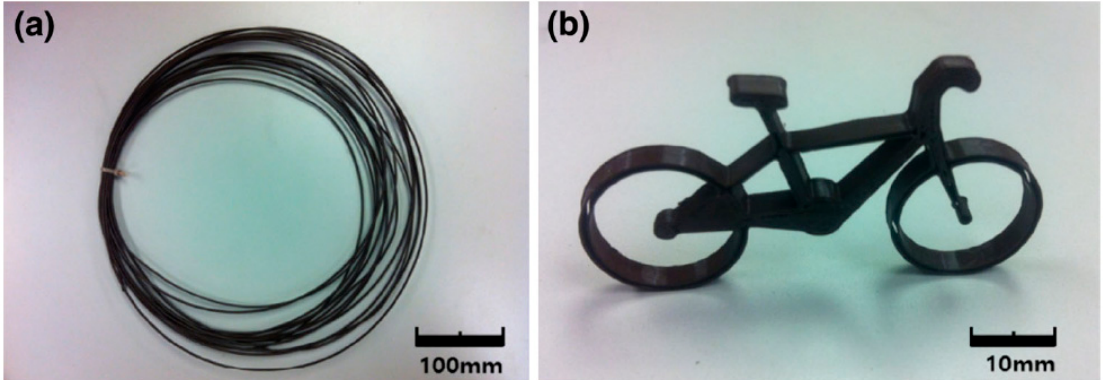
Figure 15. ABS-Cu filament and 3D structure: ( a ) fused deposition modeling (FDM) filament and ( b ) bike key chain. Reprinted from [47], © 2014, with permission from Springer Nature.